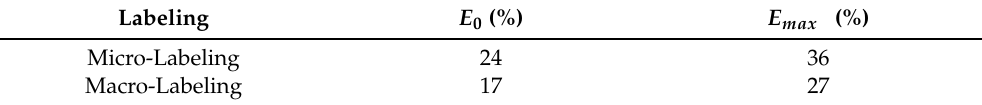
Table 3. SVM classification errors averaged over 50 participants for HBI 0 and HBI 97